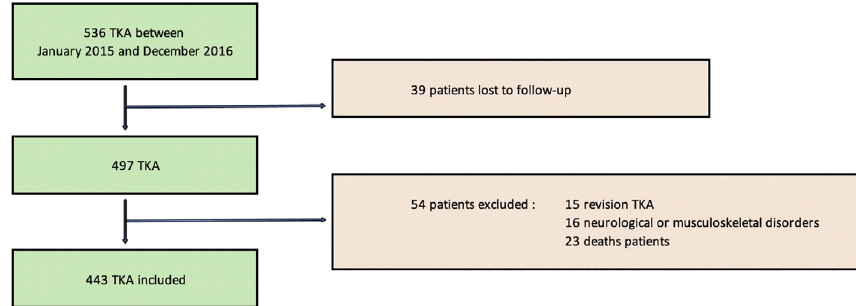
Figure 1. Flowchart of the study (RTKR: revision TKR).